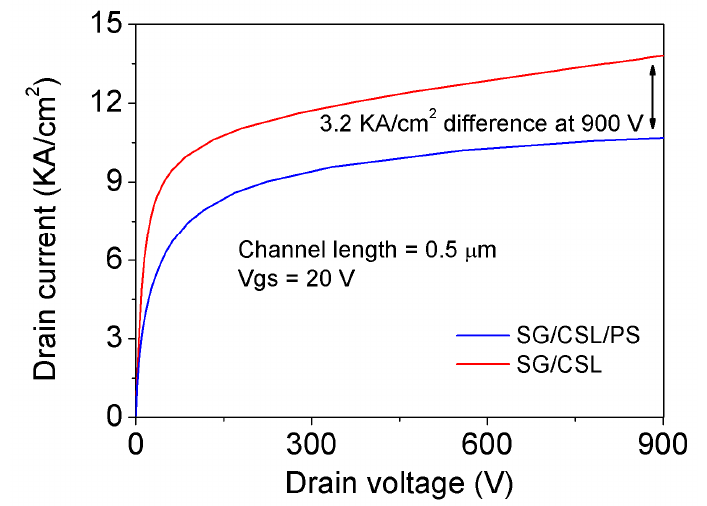
/ CSL and SG / CSL / PS.